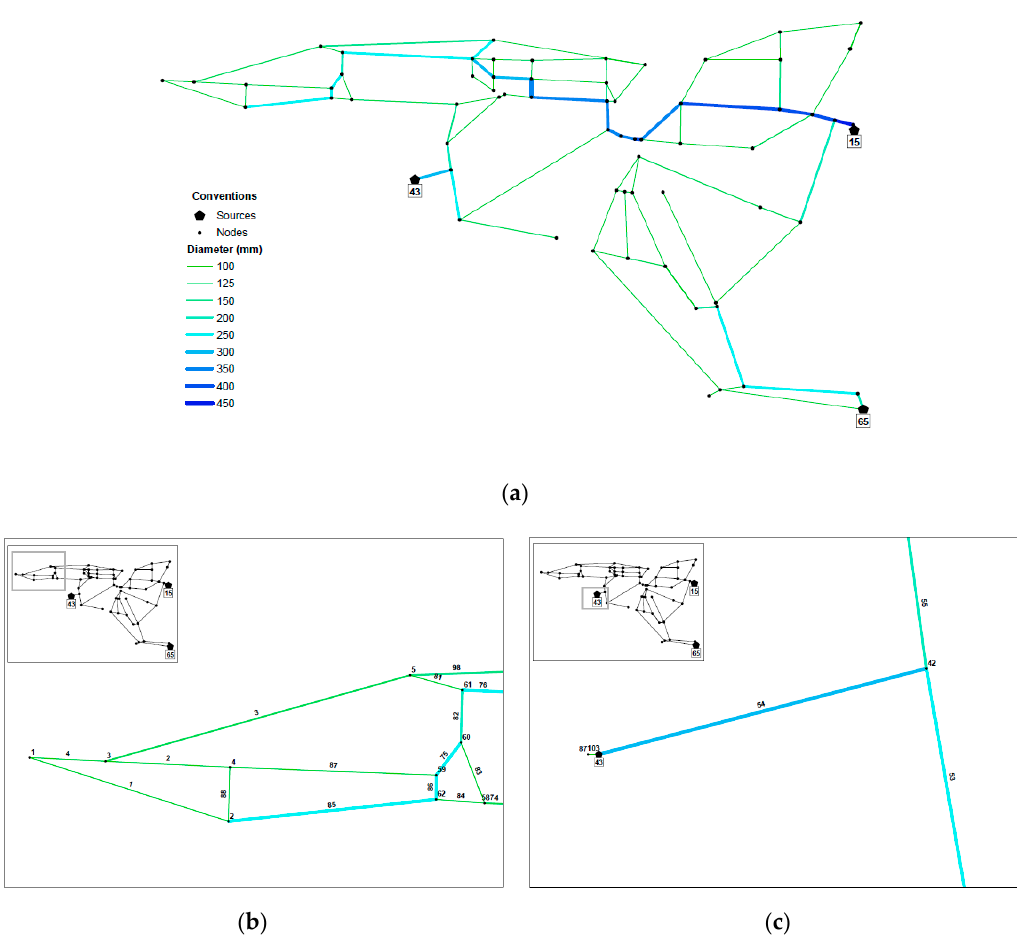
Figure 12. ( a ) OPUS design for Pescara Network. The diameters are shown in millimeters. The resulting spanning tree is shown in Figure 4b. ( b ) Zoom in to the location of Pipe 84. ( c ) Zoom in to the location of Pipe 103.